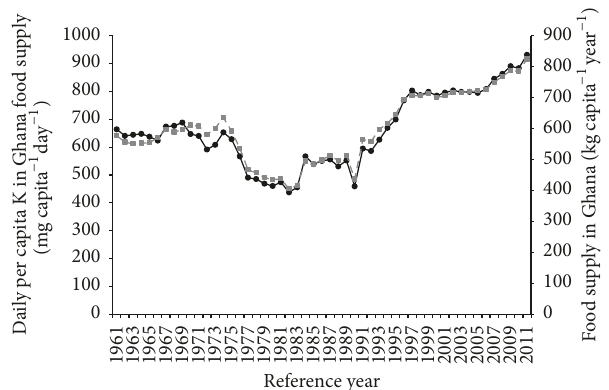
Figure 2: Trend in daily per capita K in food supply and per capita food supply in Ghana for the period 1961–2011. Mean daily capita − 1 K content (primary axis, filled black circles with continuous line); food supply in Ghana (secondary axis, filled grey squares with broken